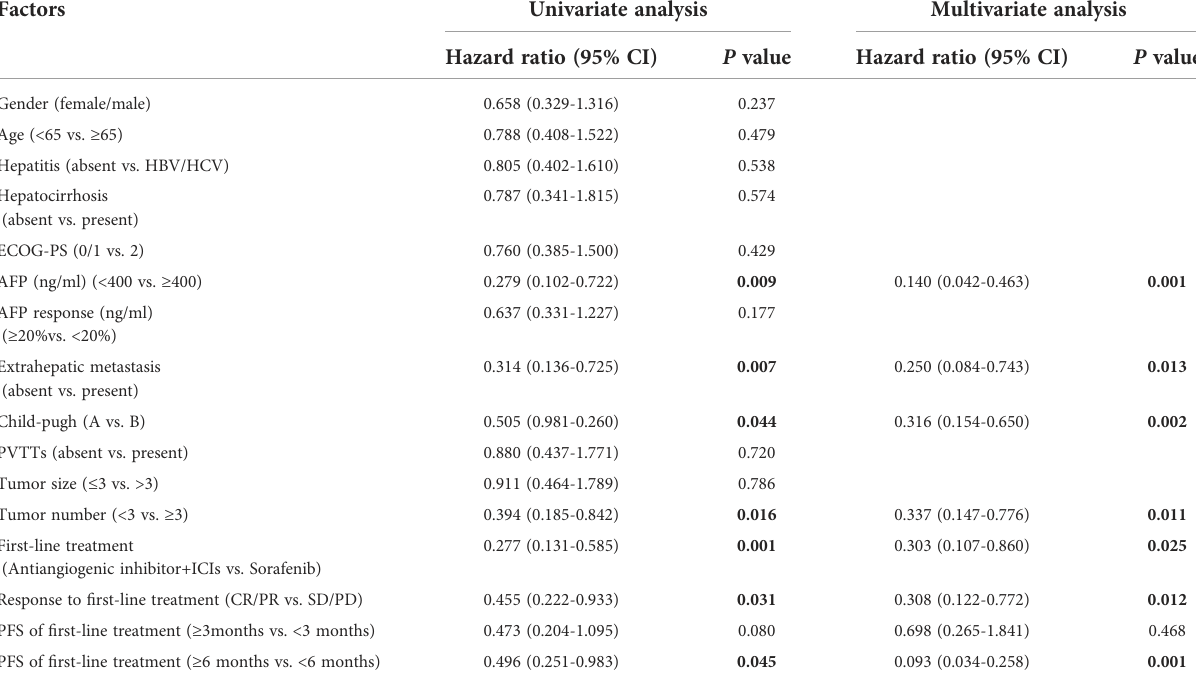
TABLE 4 Univariate and multivariate analysis of PFS in the 50 patients with unresectable HCC who received lenvatinib as second-line treatment.